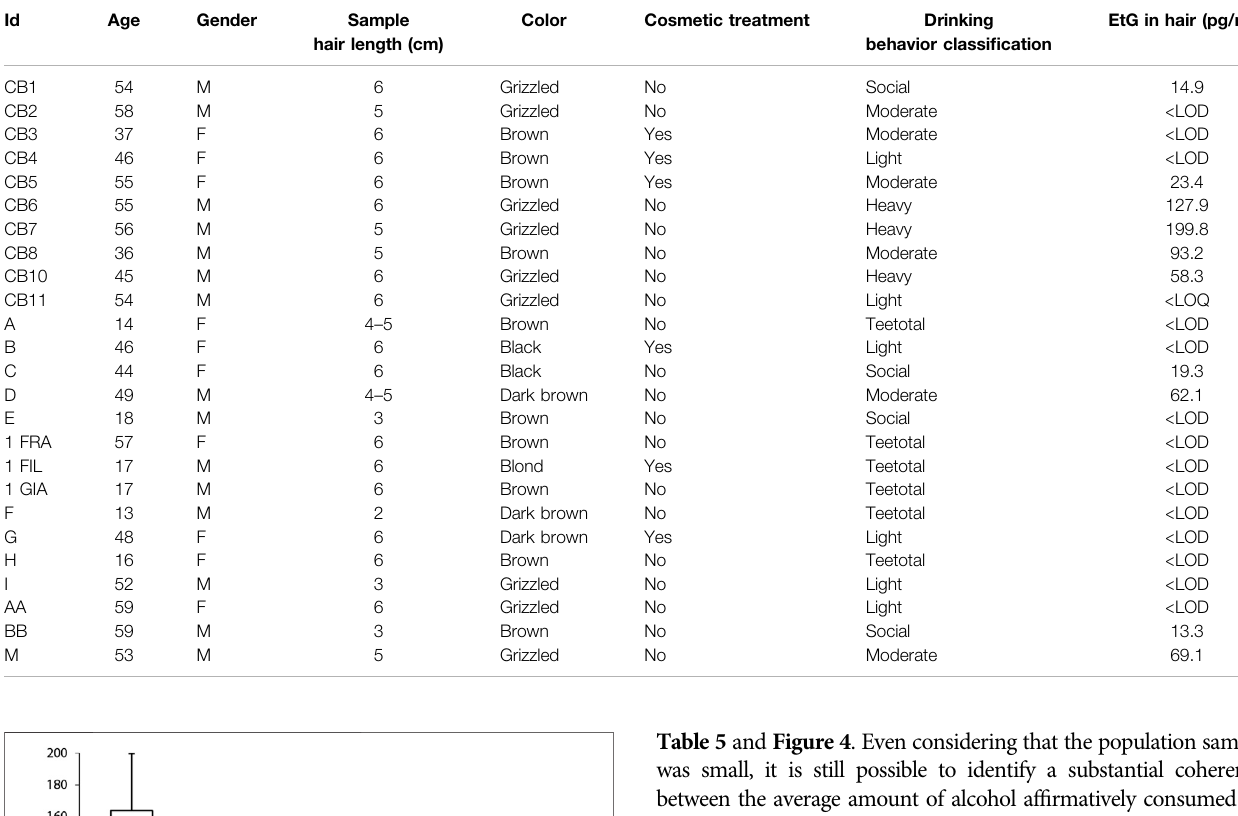
TABLE 5 | General information of the donors and data related to the hair collected. The last two columns relate to the classi fi cation of alcoholic habits derived from the questionnaire completed by each subject and the quantity of EtG found in the hair. Id